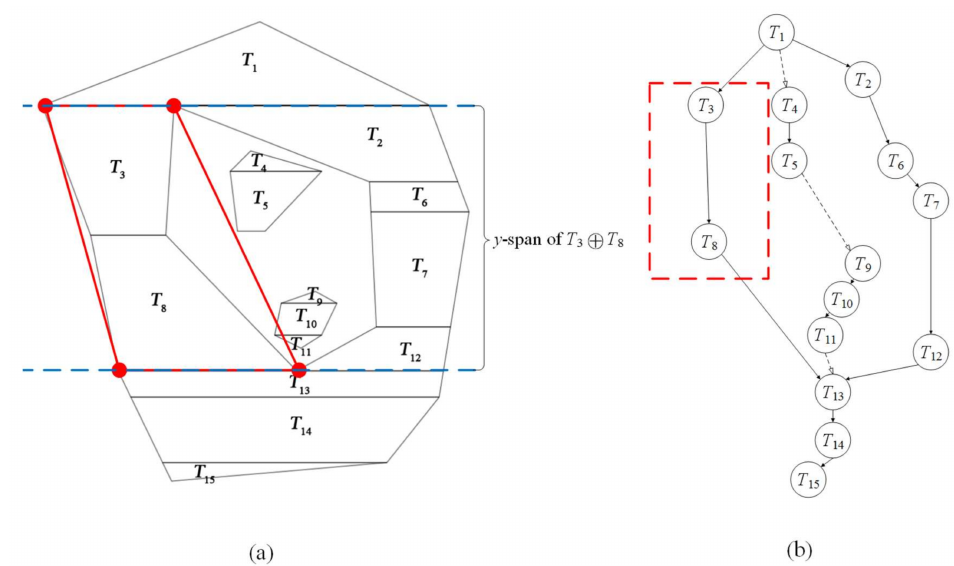
Figure 6. Trapezoid tracking to check for possible intersections. ( a ) is the tessellated result, ( b ) is the trapezoidal